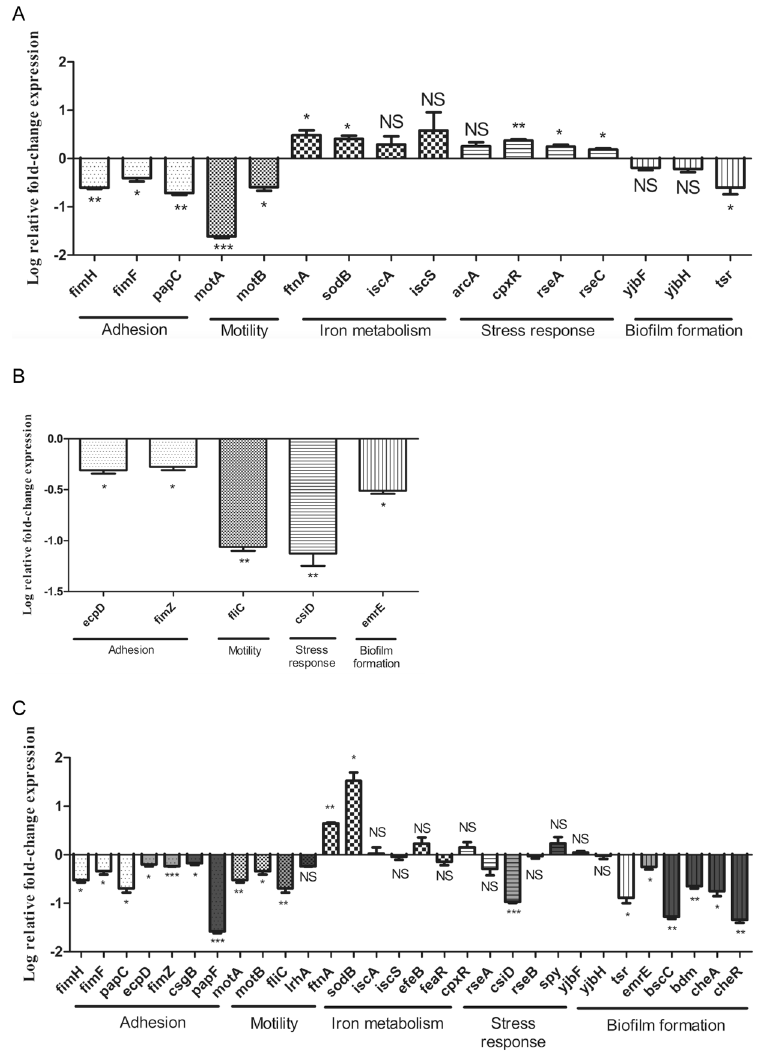
Figure 2. Log relative fold-change in mRNA expression by qRT-PCR of genes involved in adhesion, motility, biofilm formation, iron metabolism and stress response for G50 strain after treatment with cranberry (190 μ g/ mL) ( A ), propolis (102.4 μ g/mL) ( B ) and combined ( C ). The average relative fold-change compared to the control urine/LB condition. The errors bars represent the standard deviation from three different